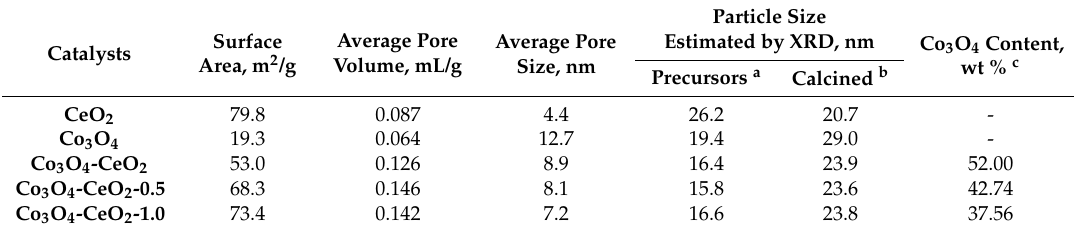
Table 1. The list of the Co 3 O 4 -CeO 2 catalysts as prepared.